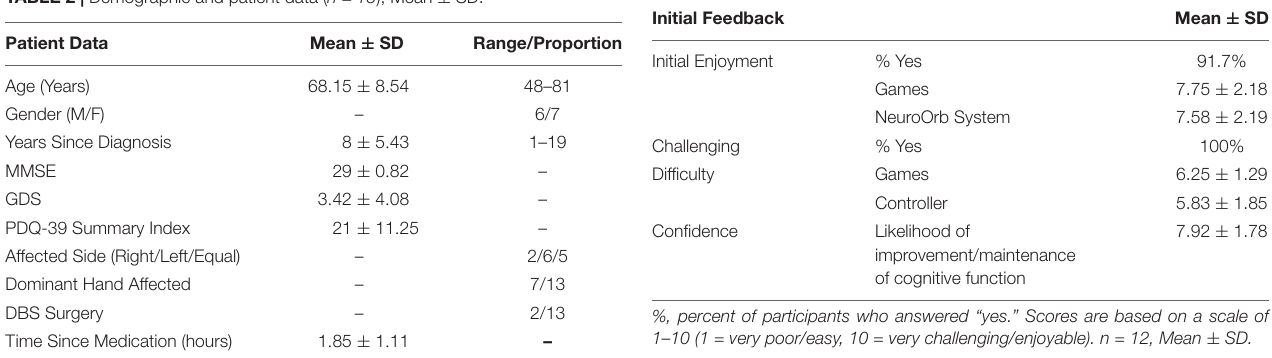
TABLE 2 | Demographic and patient data ( n = 13 ), Mean ± SD.